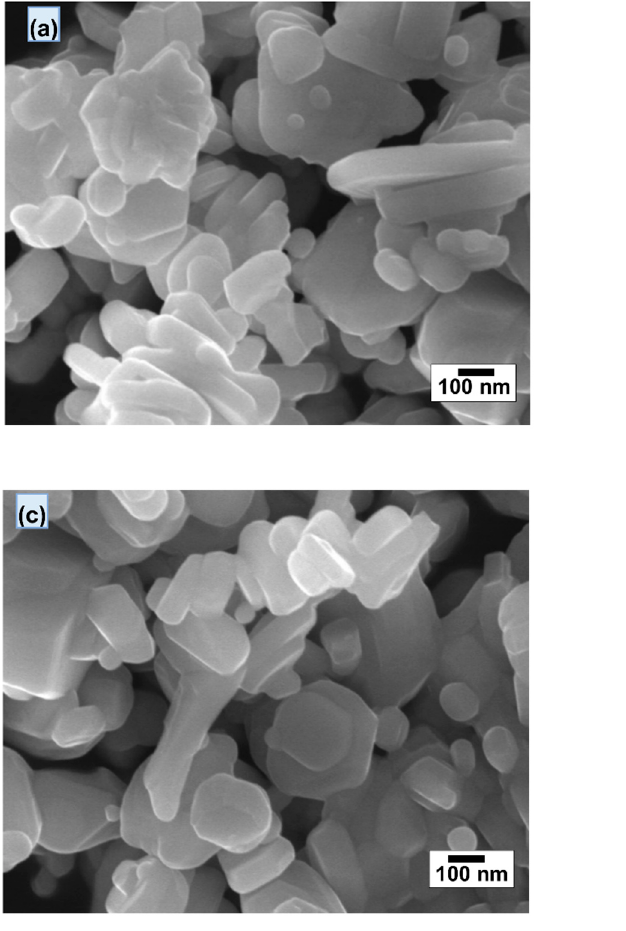
Figure 8. Scanning electron microscopy (SEM) ( a,c ) and transmission electron microscopy (TEM) ( b , d ) microphotographs obtained for SrFe 12-x Nd x O 19 powders with x = 0 ( a , b ) and 0.3 ( c , d ), respec- tively.